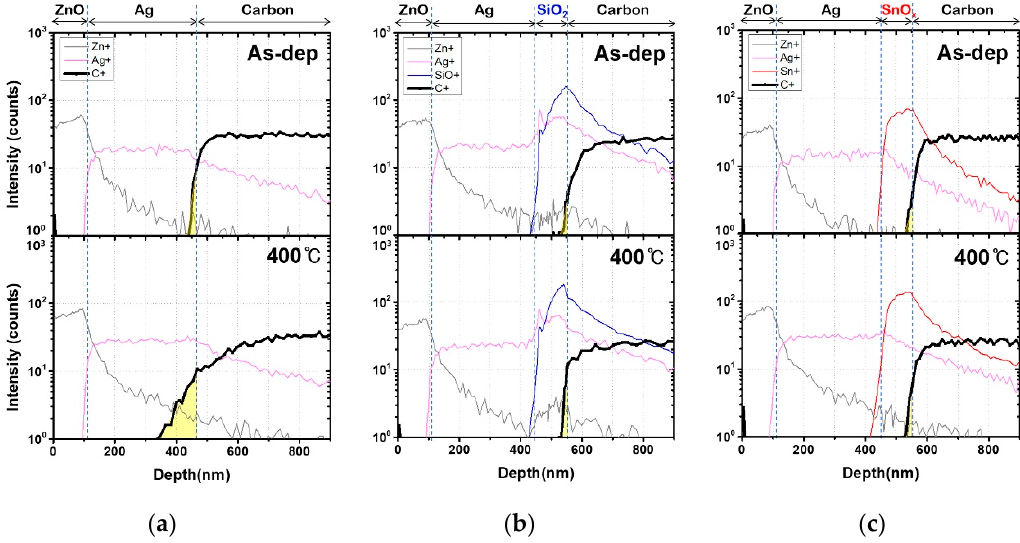
Figure 5. Secondary-ion mass spectrometry (SIMS) data before and after annealing at 400 °C with ( a )